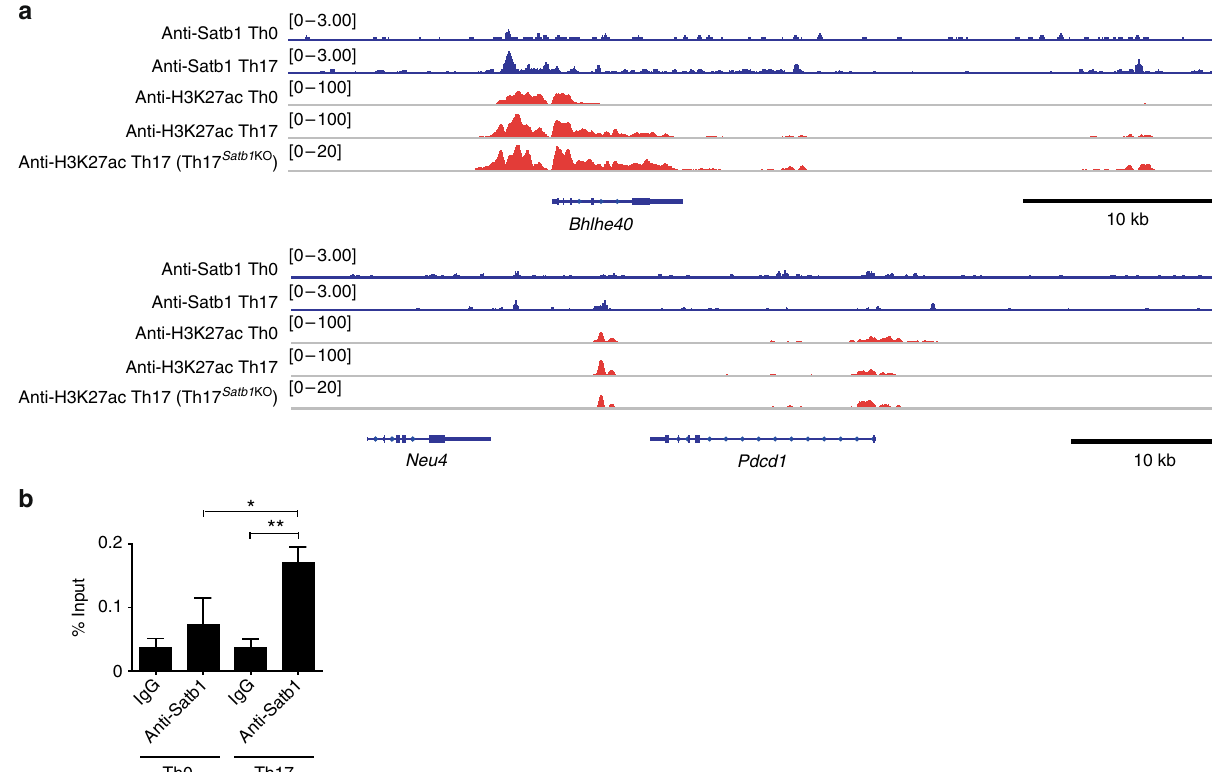
Fig. 7 Direct binding of Satb1 at the Bhlhe40 active promoter region. a ChIP-seq analyses of Satb1 binding and H3K27ac modi fi cation at the Bhlhe40 and Pdcd1 loci in in vitro polarized Th0 or eYFP + Th17 cells. b Quantitative ChIP-PCR analysis for Satb1 binding to the Bhlhe40 promoter region. Chromatin from in vitro polarized Th0 or eYFP + Th17 cells was immune-precipitated with anti-Satb1 antibody or control IgG. Percent of input before IP (1% gel input values) was quanti fi ed by real-time qPCR using primers speci fi c for Bhlhe40 promoter region. The bar graph shows the mean ± s.d. ( n = 3). The results are representative of more than two independent experiments. * P < 0.05; ** P < 0.001 (two-tailed unpaired Student ’ s t